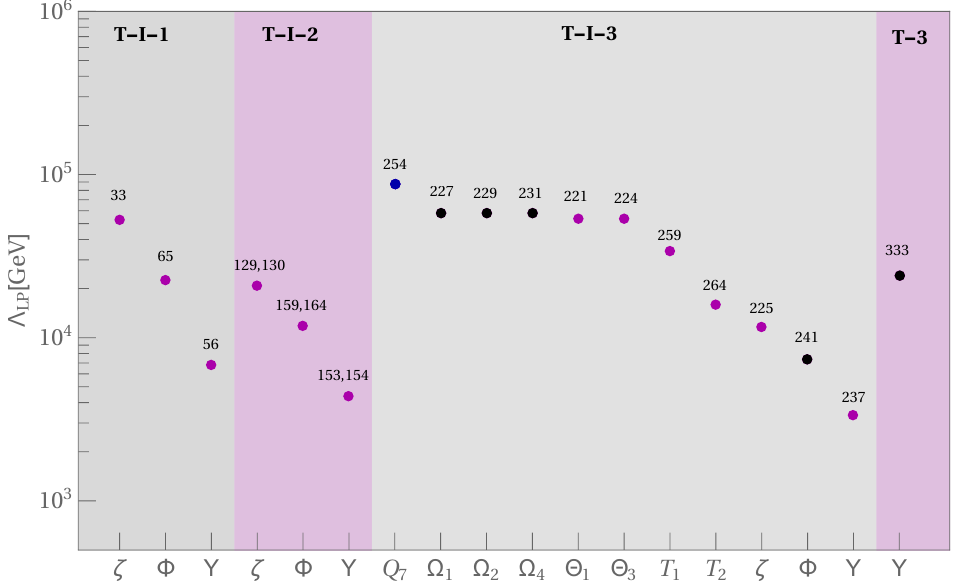
Figure 3 . The fields shown on the x-axis correspond to the scalar/fermionic exit associated with the set of models where some Landau pole occurs at a low energy, Λ LP represent the model(s) with the minimal LP and colours blue, magenta and black if such minimal LP correspond to Λ LP , Λ LP or Λ LP , respectively. The number above each point refers to the 1 2 3 specific model as listed in the tables in the